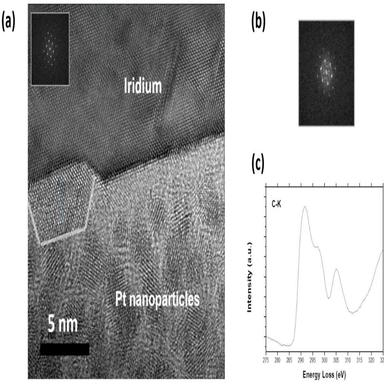
(a) HRTEM bright field image of a diamond nanocrystal at the surface of the Ir monocrystalline epilayer which underwent the BEN step. This nanocrystal is identified by a white contour; Platinum nanoparticles from the protective coating are observed on the HRTEM image. (b) Fast Fourier Transform of the HRTEM image of the diamond nanocrystal; (c) CeK EELS spectrum recorded on such a nanocrystal.